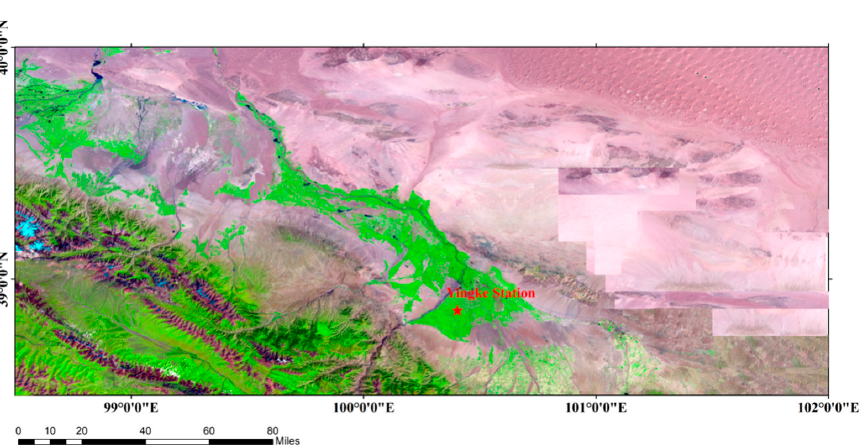
Figure 1. A quick view of the study area and location of the eddy covariance (EC) station on the Landsat TM mosaic image of the Heihe River Basin (2010) (composited by bands 5, 4, and 3. Sources: National Tibetan Plateau Data Center, 2013).